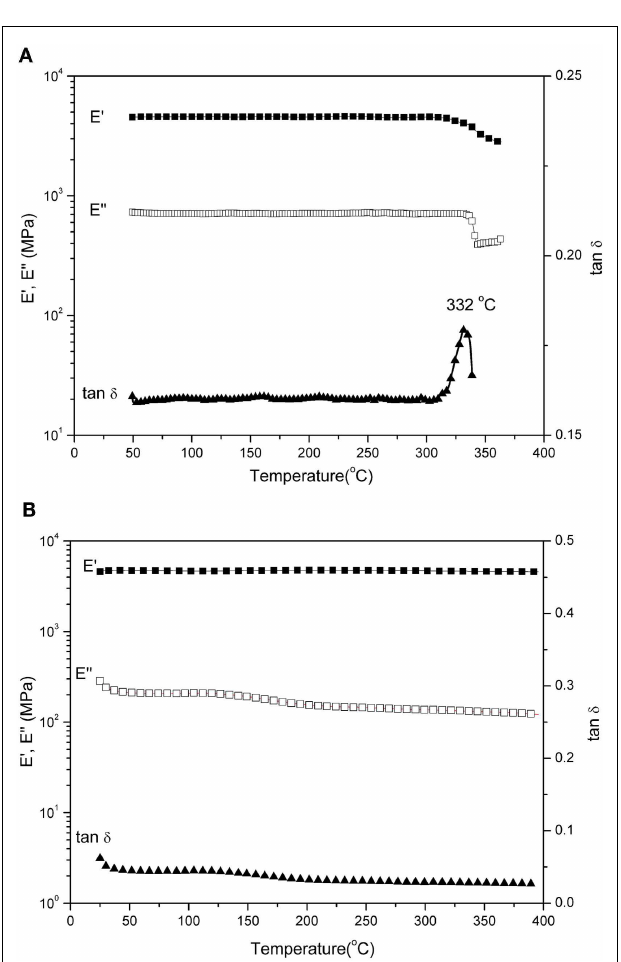
FIGURE 10 | Differential scanning calorimeter of o AI-ddm after various thermal treatments .